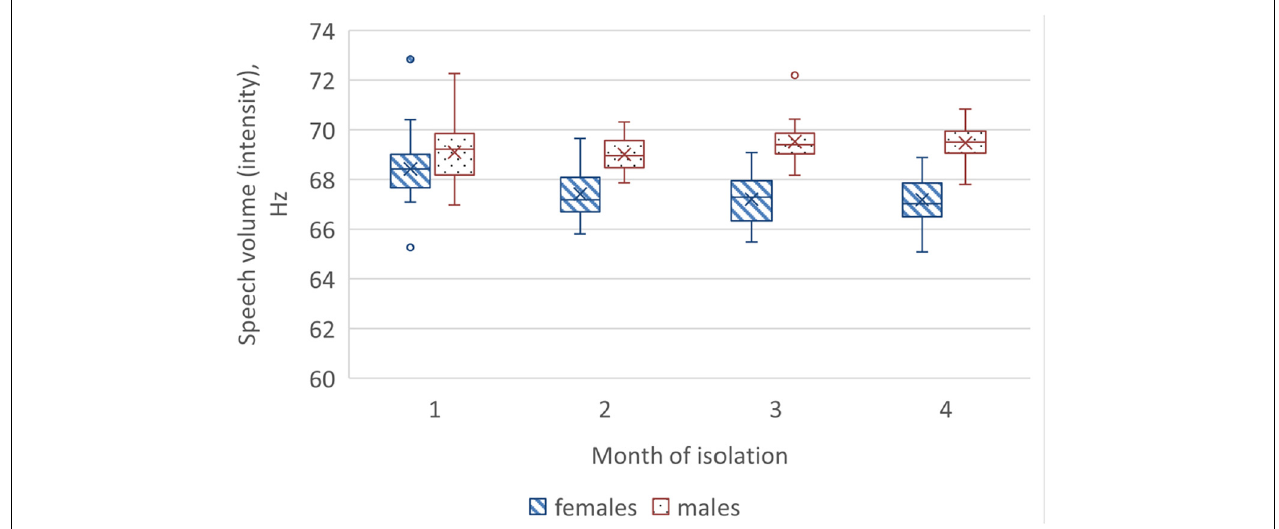
FIGURE 5 | Dynamics of speech volume in female and male crew members during isolation.